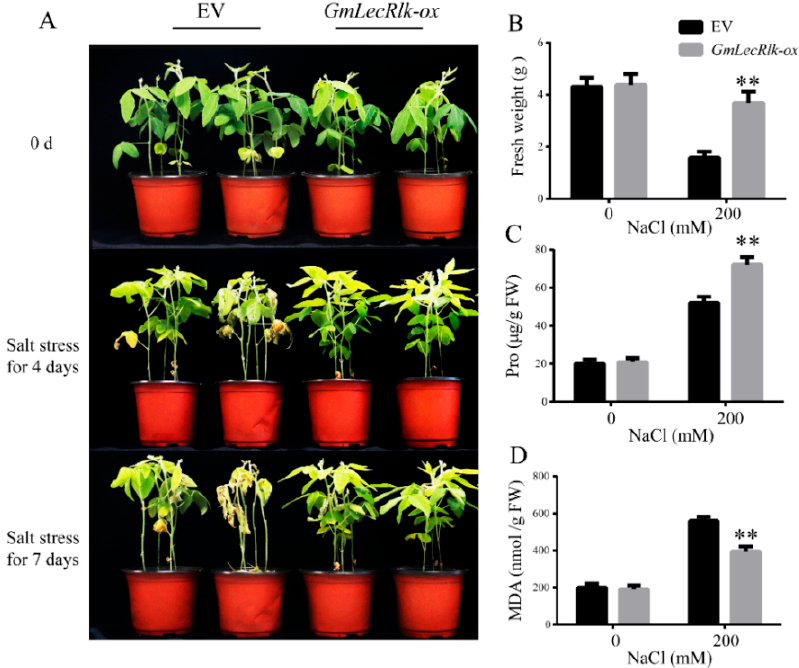
Figure 4. Phenotype identification of GmLecRlk under salt treatment in transgenic soybean hairy root compound plants. ( A ) Phenotypic analysis of GmLecRlk -ox and EV soybean hairy root compound plants grown under 0 or 200 mM NaCl; ( B ) fresh weight of GmLecRlk -ox and EV soybean hairy root compound plants with 0 or 200 mM NaCl after 7 days; ( C , D ) pro and MDA content in GmLecRlk -ox and EV soybean hairy root compound plants with 0 or 200 mM NaCl after 4 days. **, GmLecRlk -ox soybean hairy root compound plants showed a significant difference from EV ( p < 0.01). Error bars,